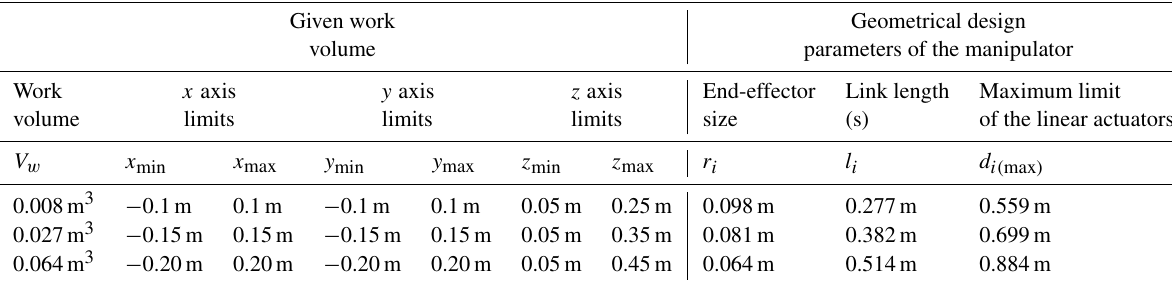
Table 1. Optimized geometrical design parameters of the manipulator Given work Geometrical design volume parameters of the manipulator Work End-effector Link length Maximum limit